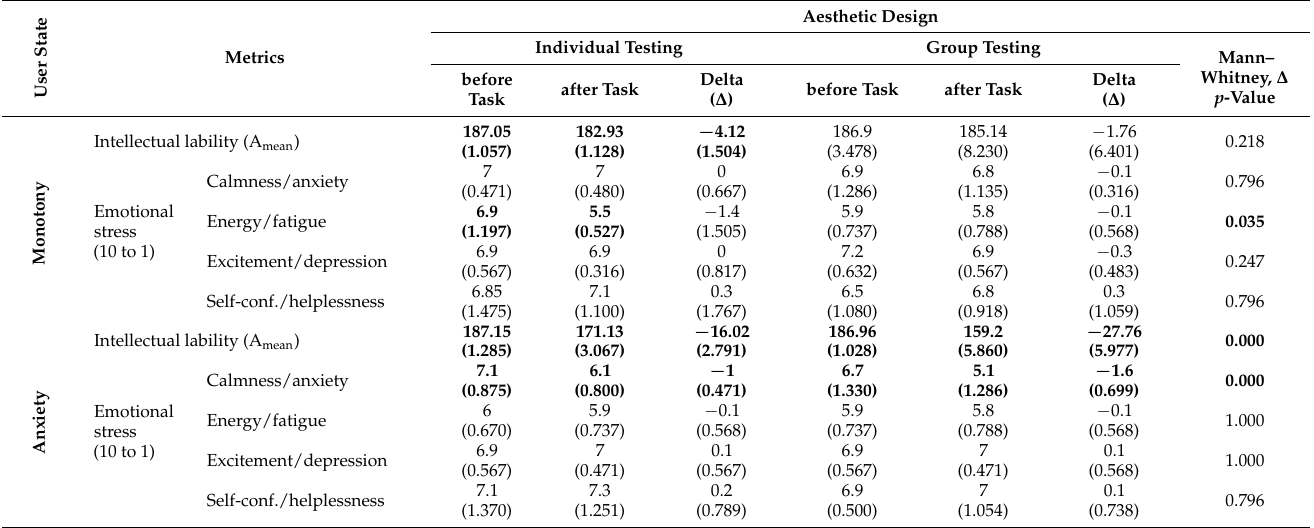
Table 5. The results of the experiment, aesthetic design, individual vs. group testing.